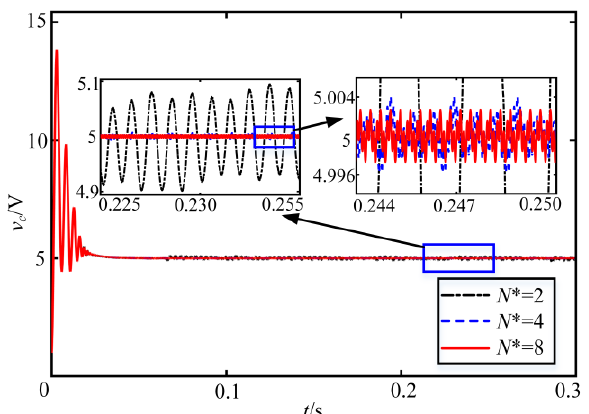
Figure 6. Comparative simulations with different N *. Table 2. Performance comparisons of the buck converter system in rated working case.